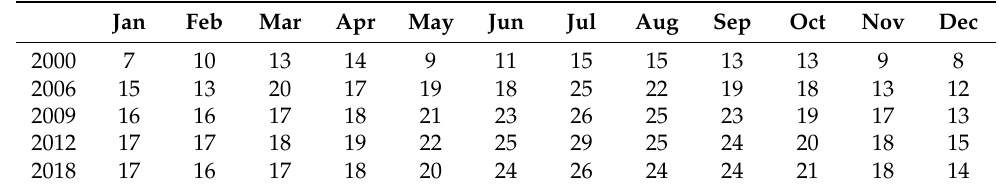
Table 3. Nitrate values in the wellfield water for five years, between 2000 and 2018 (concentrations in